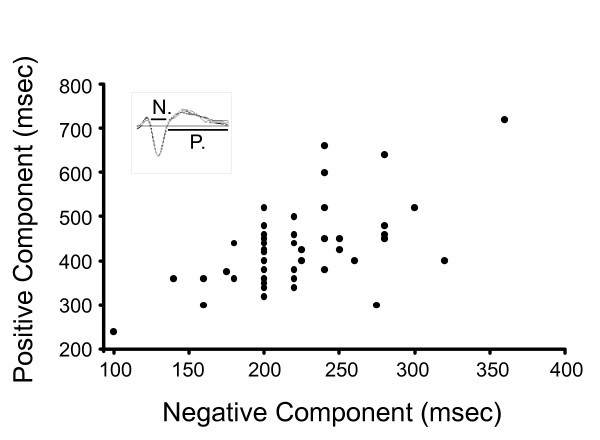
Neuronal subclasses could not be distinguished by their waveform morphology. The inset shows representative waveforms, with the negative (N) and positive (P) components indicated. When the positive component was plotted against the negative component, data points formed a single cluster.